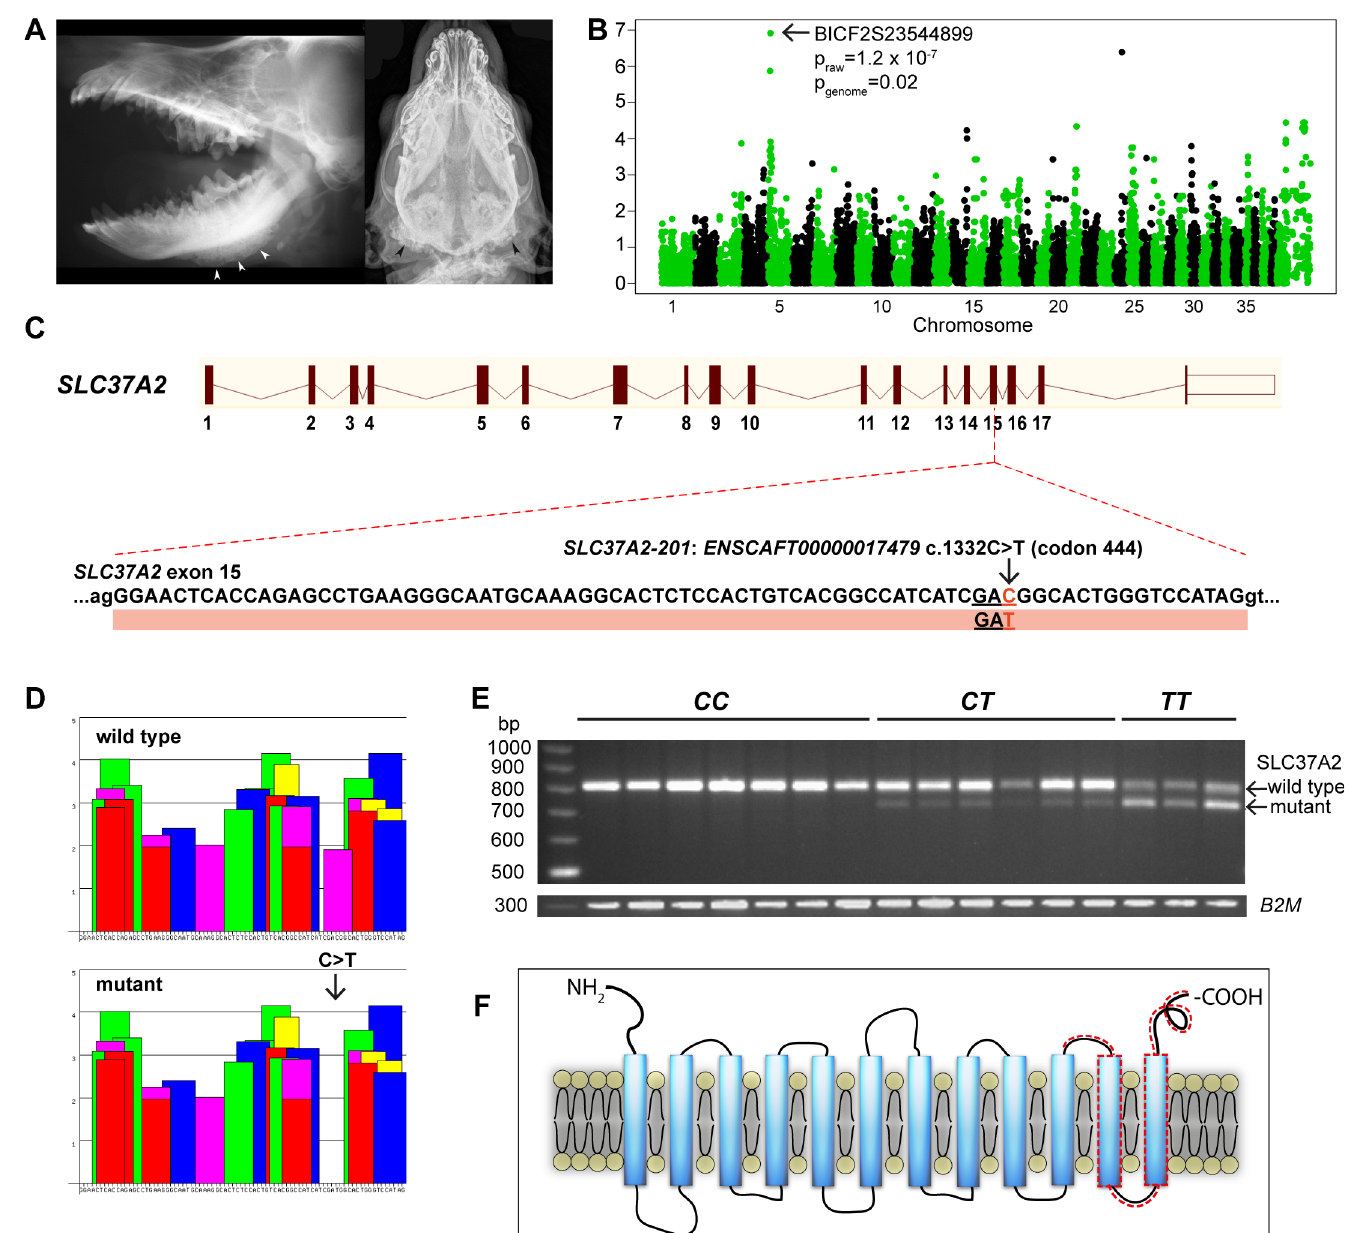
Fig 1. Genetic analyses in canine craniomandibular osteopathy identify a leaky splicing variant in exon 15 of SLC37A2 , resulting in a frameshift that truncates the protein. A . Laterolateral (left) and ventrodorsal (right) radiograph of the skull of two different WHWT affected with CMO. The typical palisade-like periosteal new bone formation is commonly located along the corpus mandibulae (left, white arrowheads) or around the Bulla tympanica (right, black arrowheads). B. Manhattan plot from GWAS indicates the associated region on chromosome 5 (p genome = 0.02). C. A synonymous variant, c. 1332C > T, in exon 15 of SLC37A2 . D . ESEfinder suggests that the synonymous variant affects a splicing enhancer site. The binding scores for the different splicing factors (colored blocks) for 79 nucleotides of exon 15 are shown for the wild-type and mutant allele. The c.1332C > T mutation eliminates a potential binding site for the SF2/ASF splicing factor (shown in purple). Binding scores for different splicing proteins (shown on the y-axis) are based on different weight matrices and cannot be compared directly to each other. E . A semi-quantitative RT-PCR in the wild-type (CC), carrier (CT) and affected (TT) WHWTs confirms the splicing defect (79 bp deletion) caused by the variant, and reveals a splicing leakage in the carrier and affected dogs. B2M was used as a loading control. F . A schematic 12-transmembrane secondary structure of SLC37A2 predicted by TMHMM. The truncated region in the mutated protein is indicated by a dashed